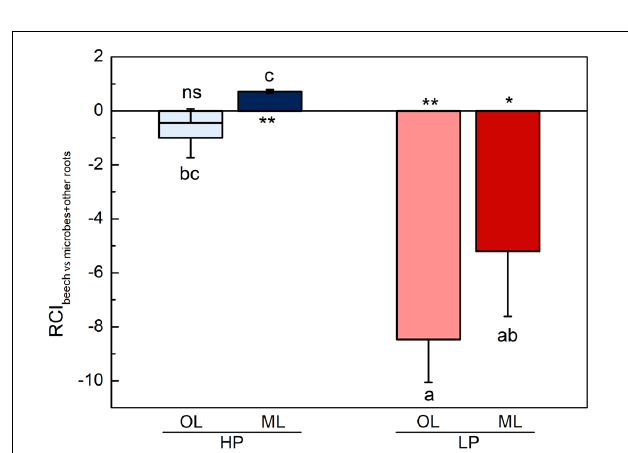
FIGURE 6 | Relative competition indices (RCIs) for P uptake of beech ( Fagus sylvatica ) roots and their competitors (microbes + other roots) in P-rich (HP: blue) and P-poor (LP: red) forest soil. Analyses were conducted separately for the organic layer (OL, light blue, light red) and the mineral topsoil (ML: dark blue, dark red). Data show means ( n = 5 ± SE per soil layer and forest type). Vertical line in bars show RCI for beech and other roots without microbes. Before ANOVA, data were normalized as follows: [log10((x − 1)* − 1)]. Significant deviation from zero are shown by different letters. To test for each variable, the non-parametric signed rank test was used and significant differences at p < 0.05 and p < 0.01 are indicated by * and **, respectively. ns = not